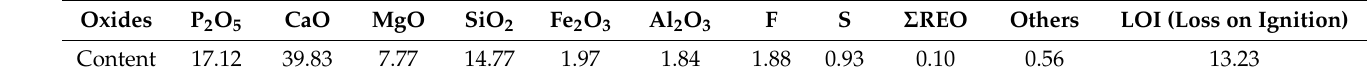
Table 1. Chemical analysis of Zhijin phosphate ore (wt%).